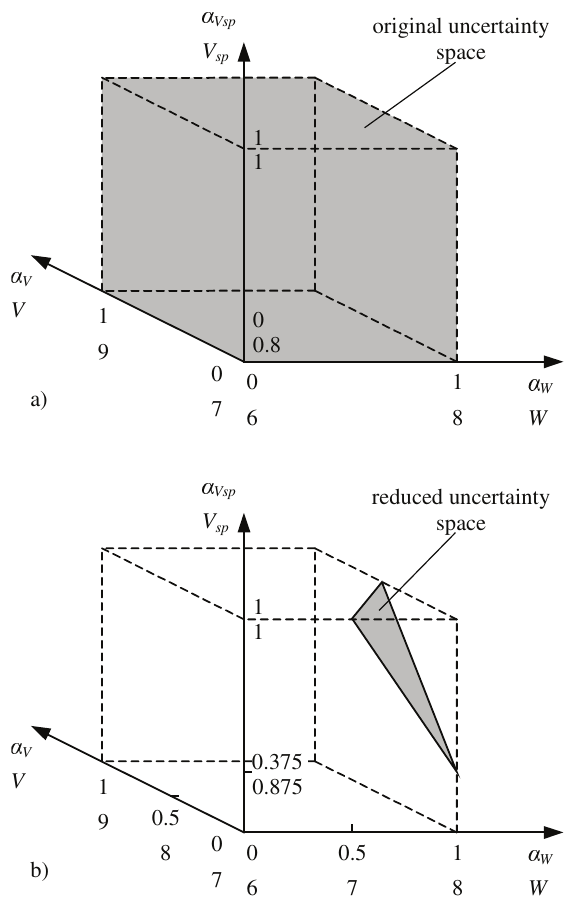
Fig. 18. Visualisation of the original uncertainty space in Example 6 (a) and the reduced space achieved thanks to the IPV-arithmetic